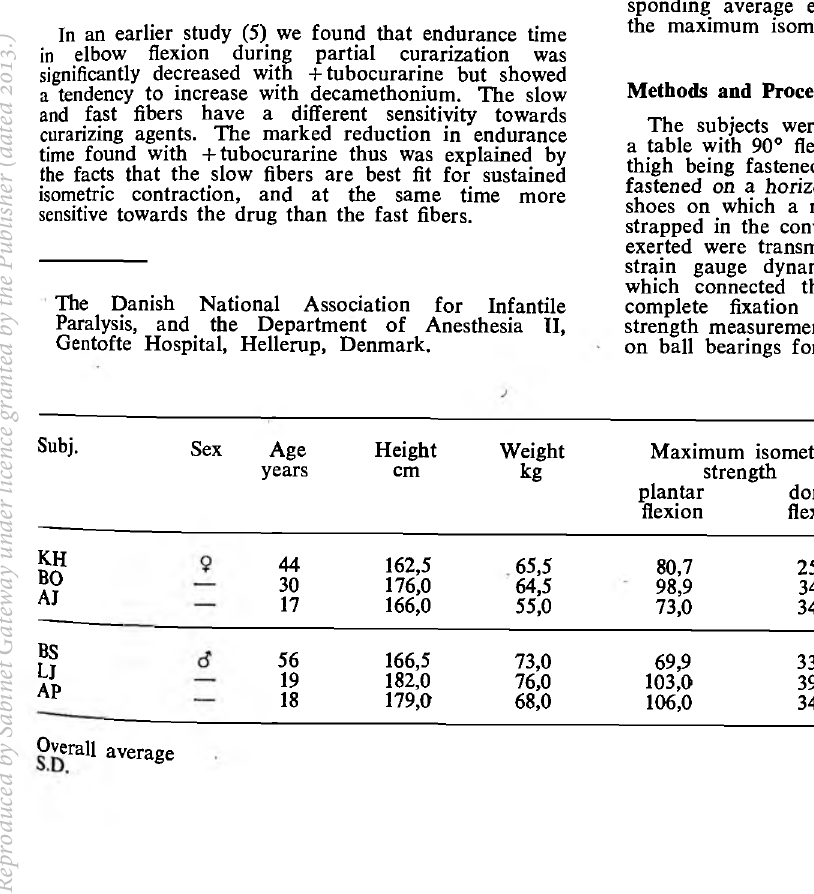
Table 1. Subjects’ data, the mean values of three mea­ surements on each subject of the maximum isometric strength in plantar and dorsal flexion, and the corre­ sponding average endurance times at approx. 50% of the maximum isometric